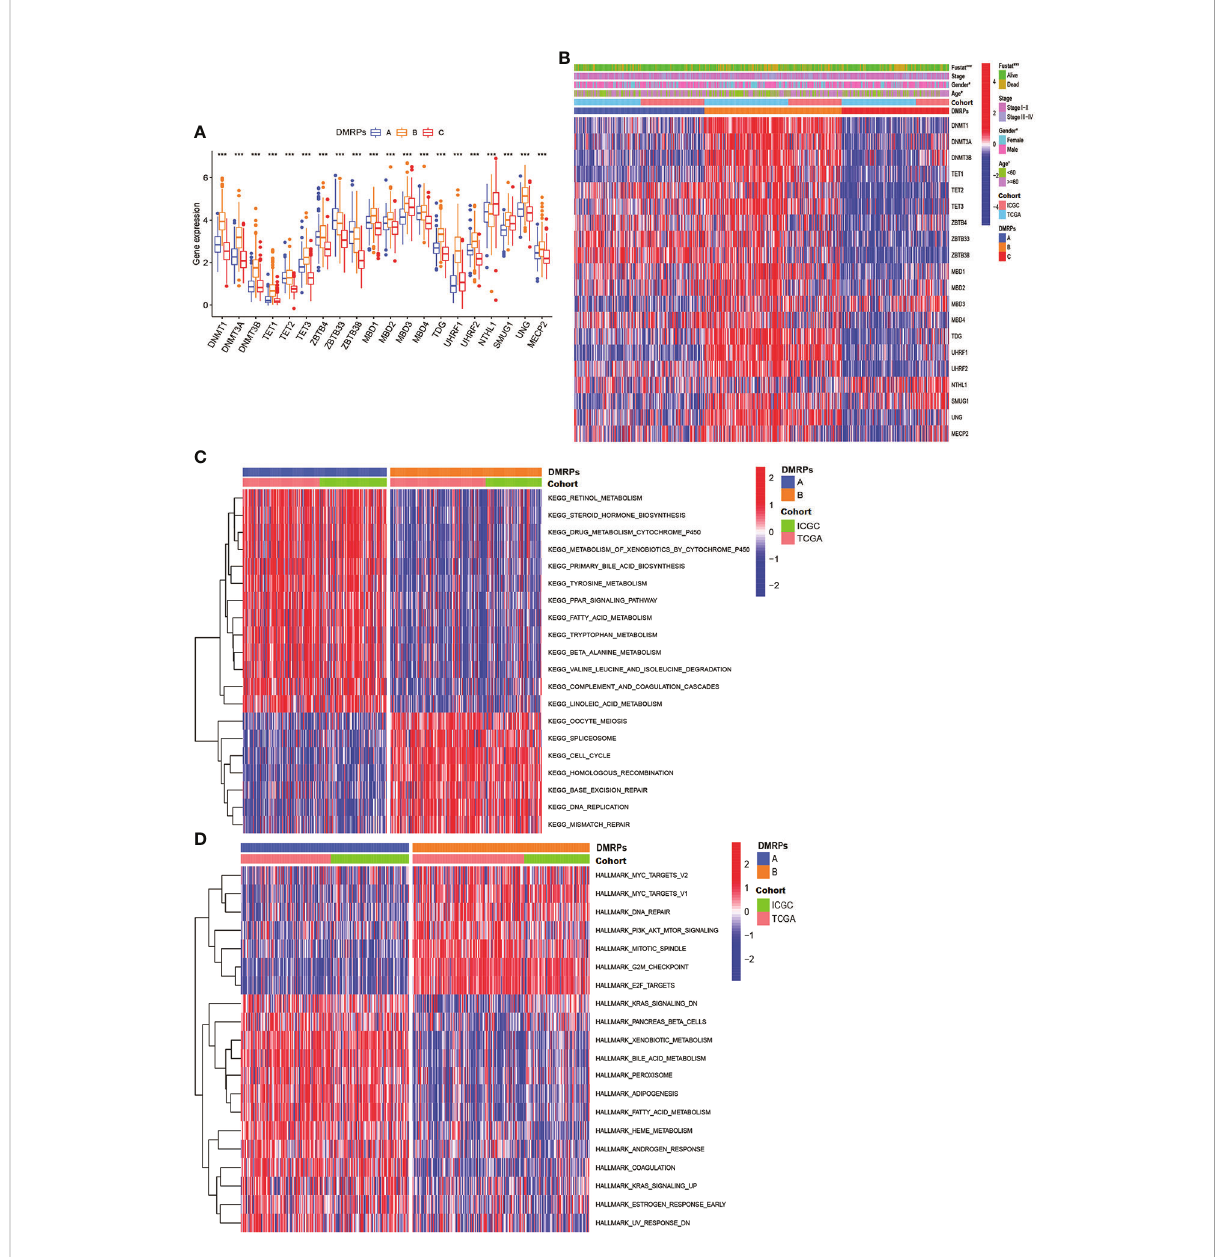
FIGURE 3 The clinical features of different DNA methylation regulator-related patterns and relevant function mechanism. (A) The expression of 20 DNA methylation regulators among three DNA methylation regulator-related patterns. (B) The heatmap of the differences between the expression of 20 DNA methylation regulators and clinicopathological factors. (C, D) GSVA showed the results of KEGG and Hallmark pathways in distinct DNA methylation regulators related modi fi cation patterns, respectively. * P < 0.05, ** P < 0.01, *** P < 0.001, **** P <